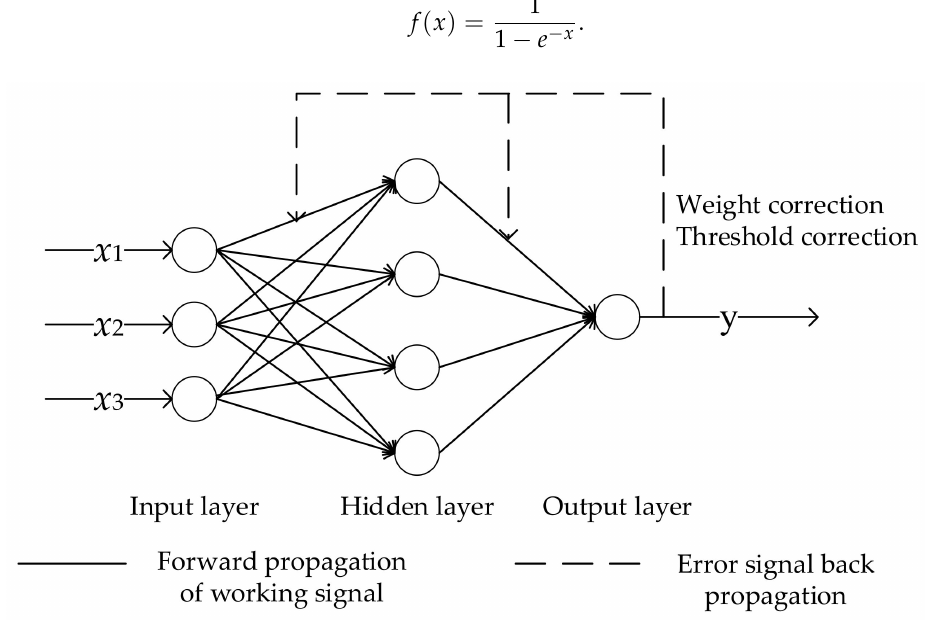
Figure 3. BP neutral network